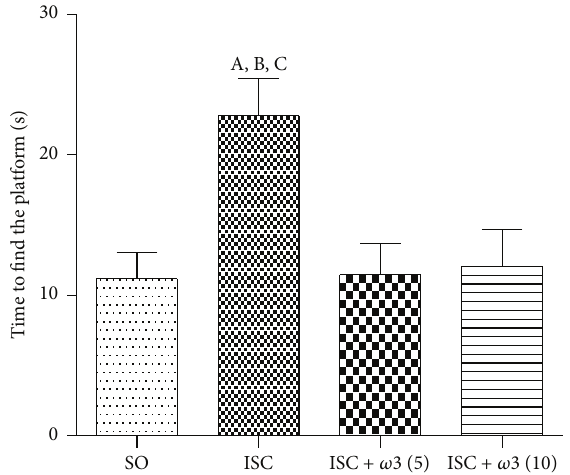
Figure 2: Evaluation of the spatial memory by the water maze test. The columns represent means ± SEM of the time (s) to find the platform. The studied groups were SO and ischemic animals untreated or after oral treatments with 𝜔 3, at the doses of 5 and 10mg/kg (number of animals per group: SO = 28; ISC = 27; ISC + 𝜔 3 (5) = 14; ISC + 𝜔 3 (10) = 14). (A) versus SO, q = 5.159 ∗∗ ; (B) versus 𝜔 3 (5), q = 4.016 ∗ ; (C) versus 𝜔 3 (10), q = 3.897 ∗∗ (one-way ANOVA and Newman-Keuls test as the post hoc